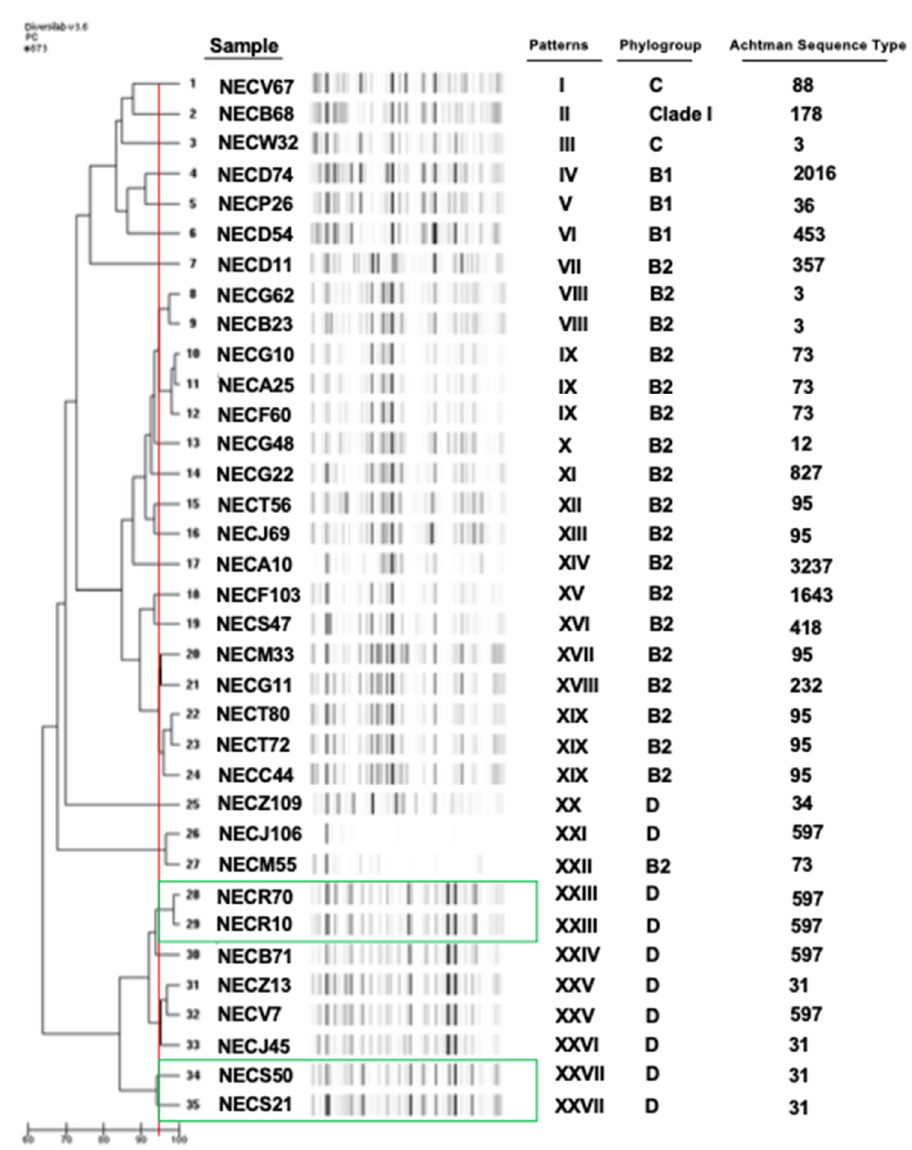
Figure 1. Genetic diversity of Escherichia coli strains isolated from diabetic foot infections using DiversiLab method, Multi-Locus Sequence Typing and phylogrouping. In green, the strains isolated at two periods in a same patient (Patient 1, NECR70/NECR10; Patient 2, NECS50/NECS21). Table 3. Distribution of virulence factors in the E. coli isolated from diabetic foot osteomyelitis (DFOM) and deep diabetic foot infection (dDFI).